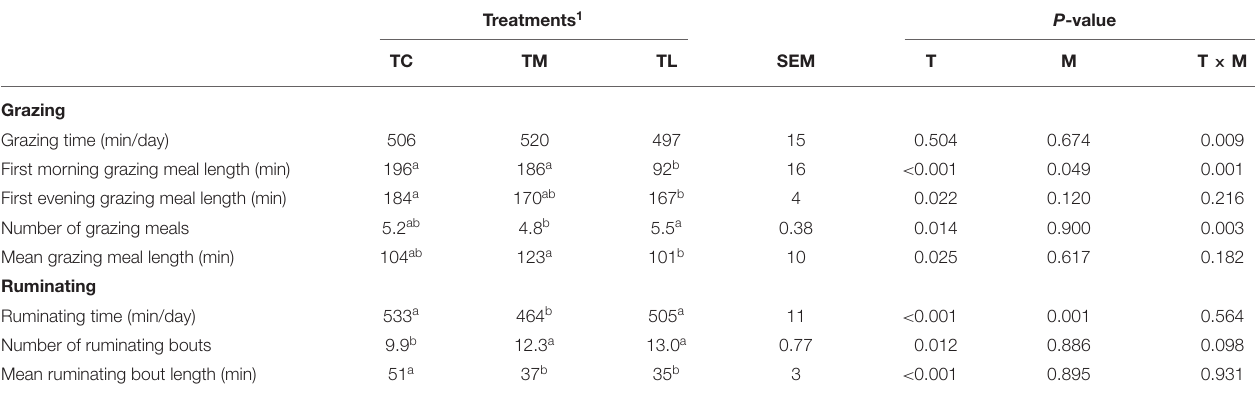
TABLE 3 | Effect of post-grazing sward height (T) and moment of occupation period (M) on ingestive and ruminating behavior by lactating cows. Treatments 1